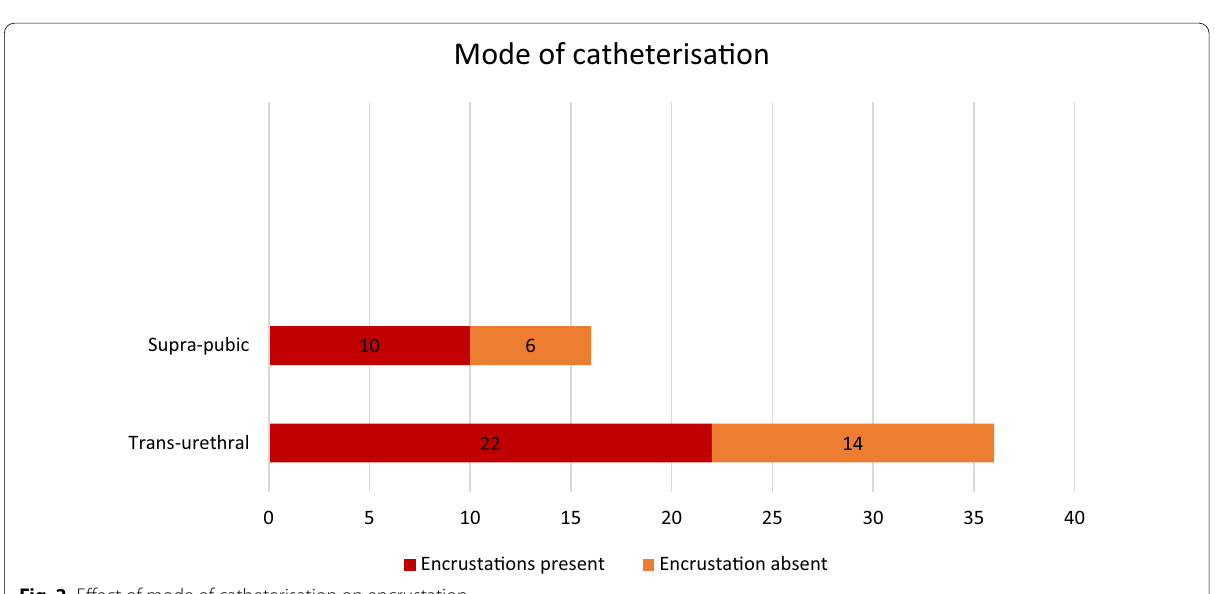
Fig. 2 Effect of mode of catheterisation on